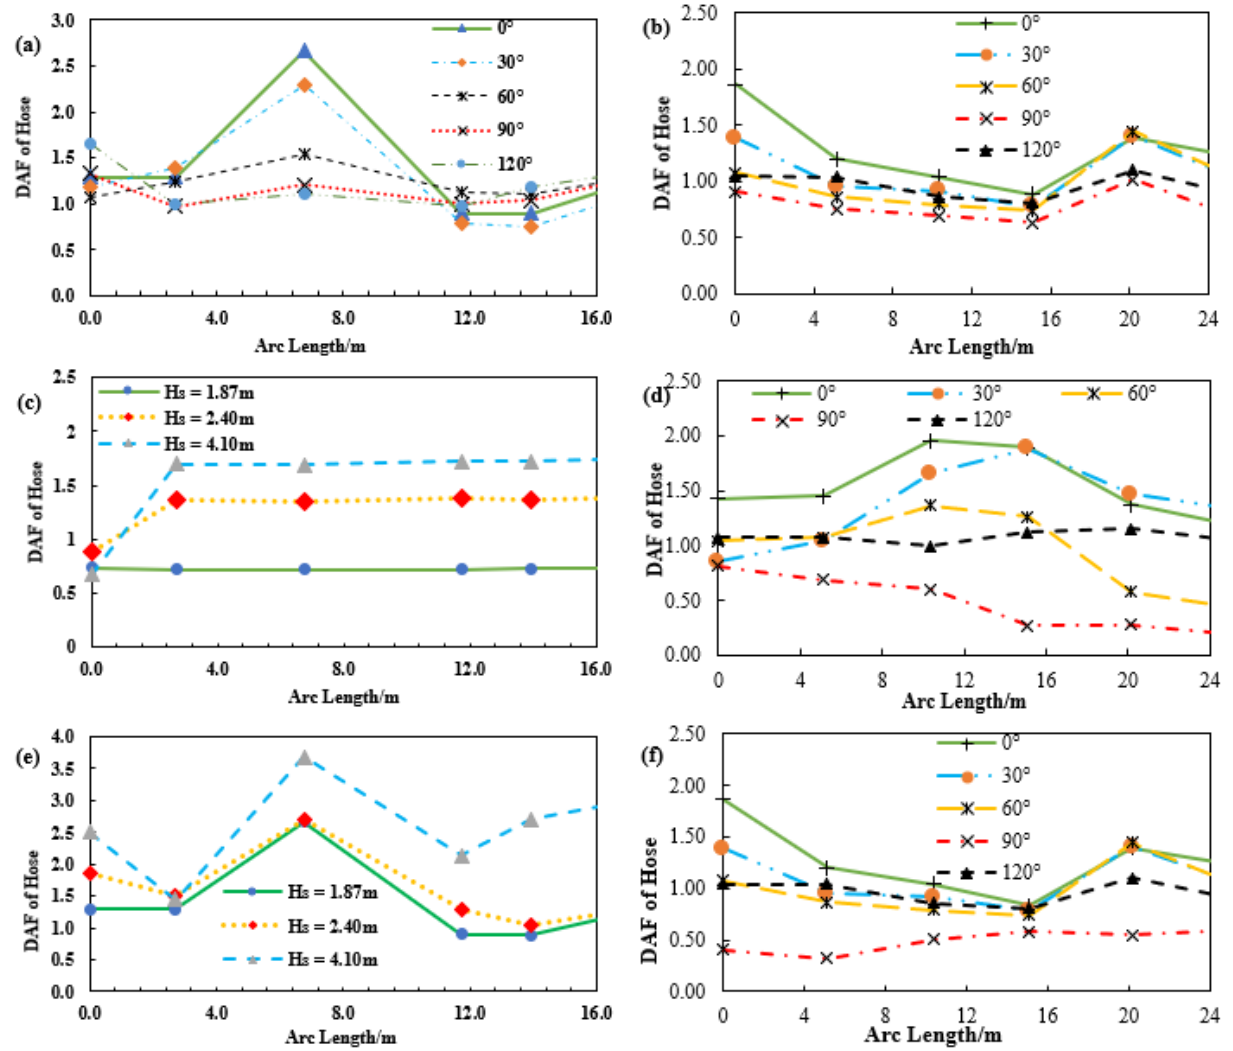
Figure 25. Influence of loadings from hydrodynamics on the DAF Hose of the submarine hose. ( a ) Cur- vature DAF Hose for the hose in Lazy-S config. ( b ) Curvature DAF Hose for the hose in Chinese-lantern config. ( c ) Effective Tension DAF Hose for the hose in Lasy-S config. ( d ) Effective Tension DAF Hose for the hose in Chinese-lantern config. ( e ) Bending moment DAF Hose for the hose in Lazy-S config. ( f ) Bending Moment DAF Hose for the hose in Chinese-lantern config.